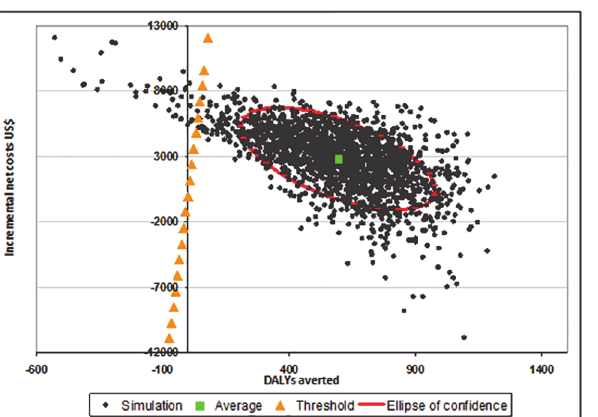
Fig 4. Cost effectiveness plane: IPTp-MQ versus IPTp-Placebo in HIV-positive pregnant women in Kenya, Mozambique and Tanzania. IPTp-MQ = Intermittent Preventive Treatment of malaria in pregnancy with Mefloquine; HIV = Human Immunodeficiency Virus; DALYs = Disability-adjusted life years. The graph plots 2,000 Monte Carlo simulations of the incremental cost-effectiveness ratio (ICER) with respect to its components: health impact (X-axis) and incremental costs (Y-axis). Average simulation point, ellipse of confidence (95%) and threshold level of the ICER (240 US$/DALY averted) are also depicted.